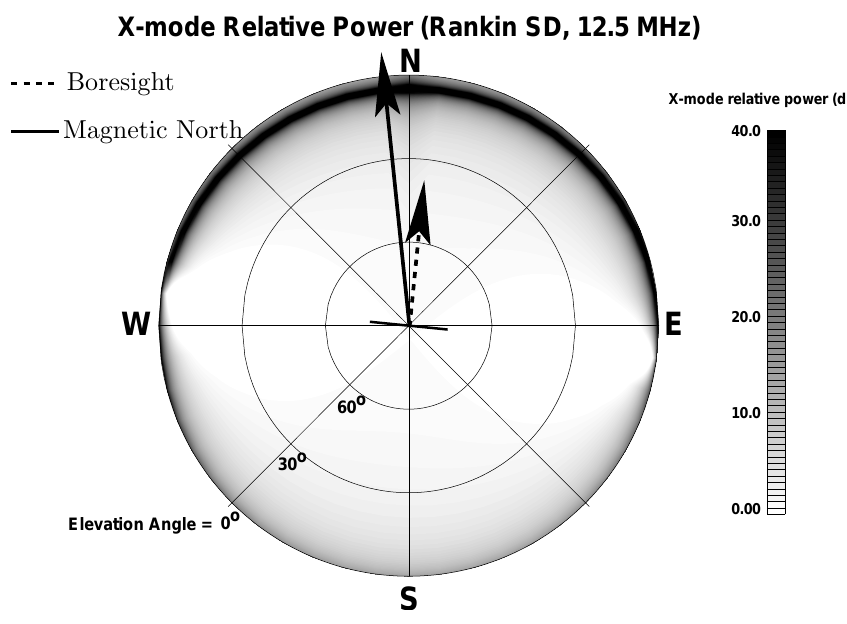
Fig. 5. Relative power delivered to the X-mode (Eq. 26) at 12.5MHz from the Rankin Inlet SuperDARN as a function of elevation and azimuth